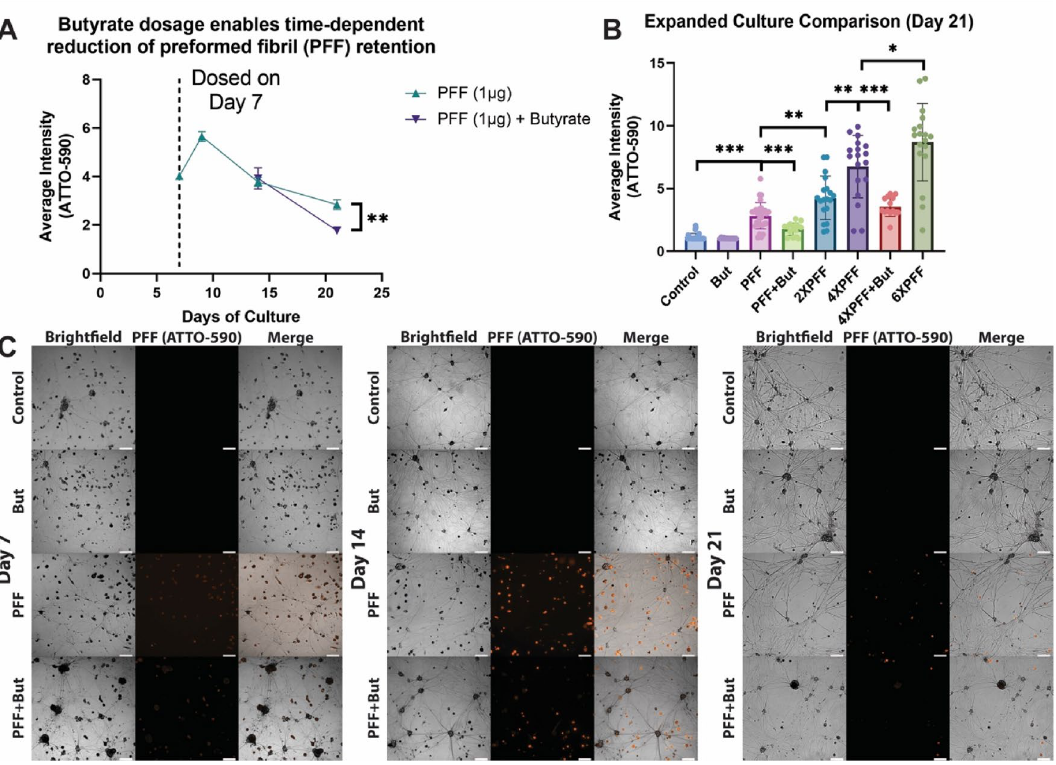
Figure 2. Live-cell imaging quantification of preformed fibril (PFF) intensity throughout experiments. ( A ) Average intensity of images across culture period. Box-cox transformed multilevel model accounting for experimental replicate and well with Tukey p-value adjustment used. N = 3–6, m = 9–21, images = 15–31. ( B ) Average intensity of images on day 21 of culture. Kruskal–Wallis test and Wilcoxon rank-sum multiple comparisons with Benjamini–Hochberg p-value adjustment utilized. N = 3–6, m = 8–20, images = 13–29. ( C ) Representative images of cultures over time between groups (orange = PFF fluorescent tag). Day 7 background signal is attributed to free-floating PFF after addition. (* p < 0.05, ** p < 0.01, *** p < 0.001). Scale = 100 µm. Pixel intensity in uint8 (values range from 0 to 255). Each dot represents an image, error bars =